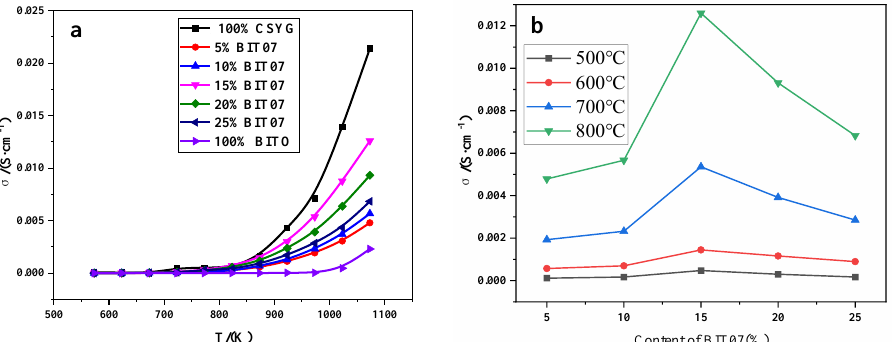
Figure 6. Ionic conductivity of CSYG-BIT07. ( a ) Ionic conductivity vs. temperature. ( b ) Ionic conductivity vs. content.